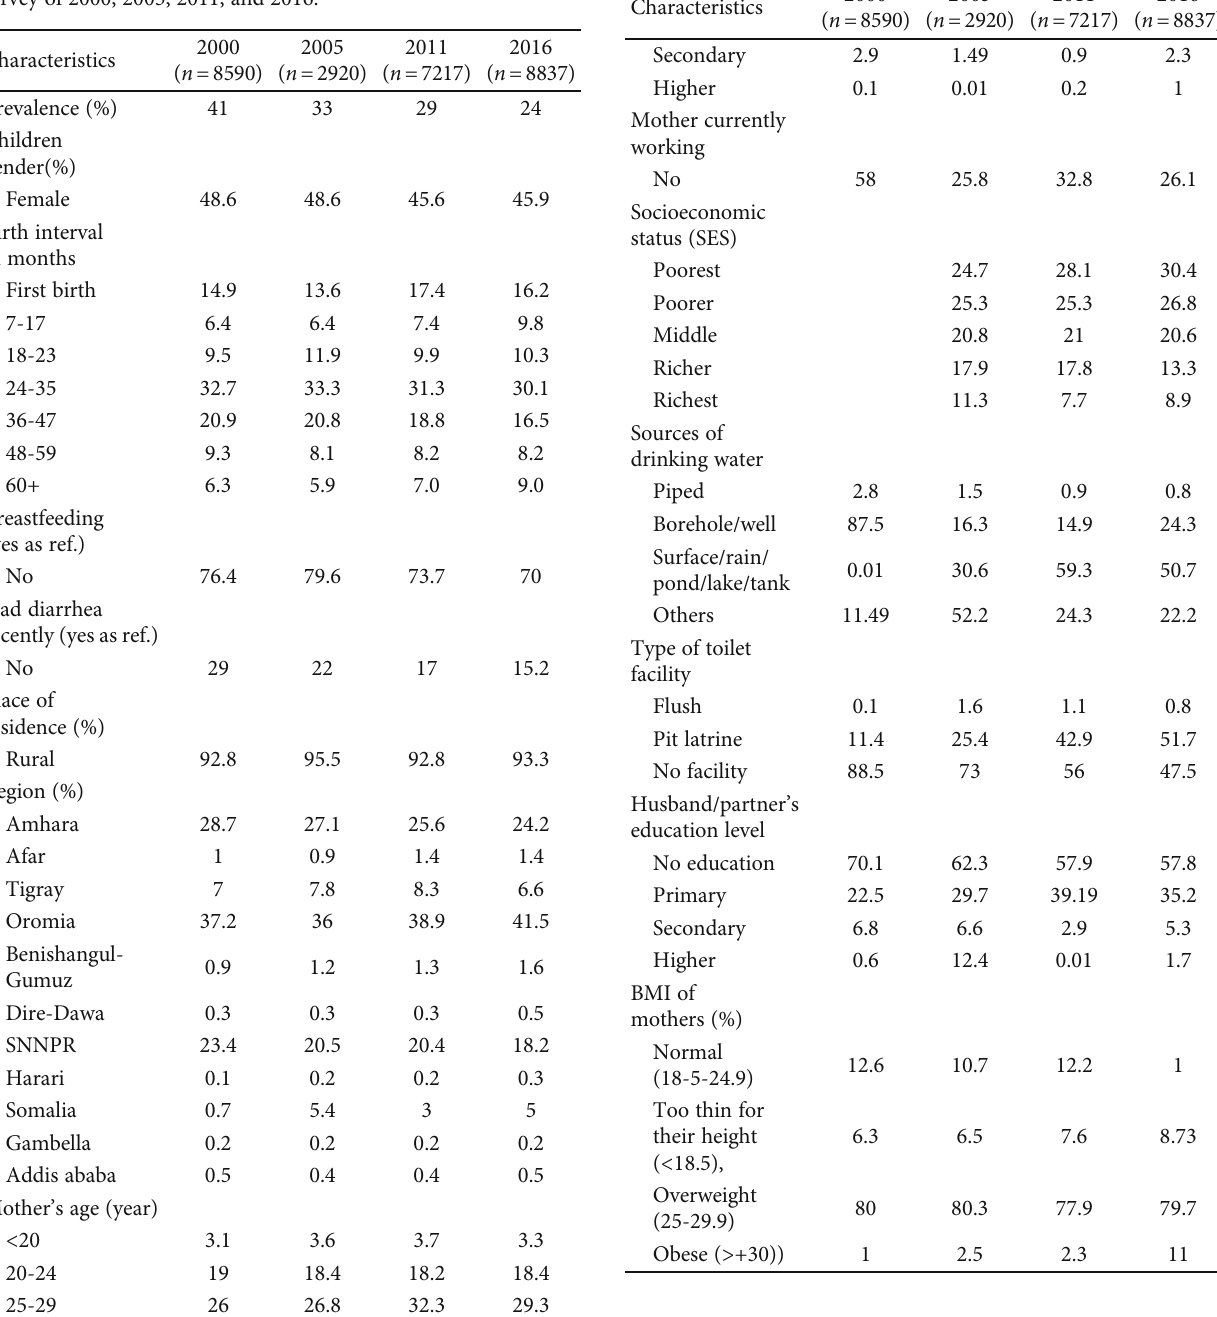
Table 1: Percent distribution of under- fi ve children, maternal and household characteristics: Ethiopian Demographic and Health Survey of 2000, 2005, 2011, and